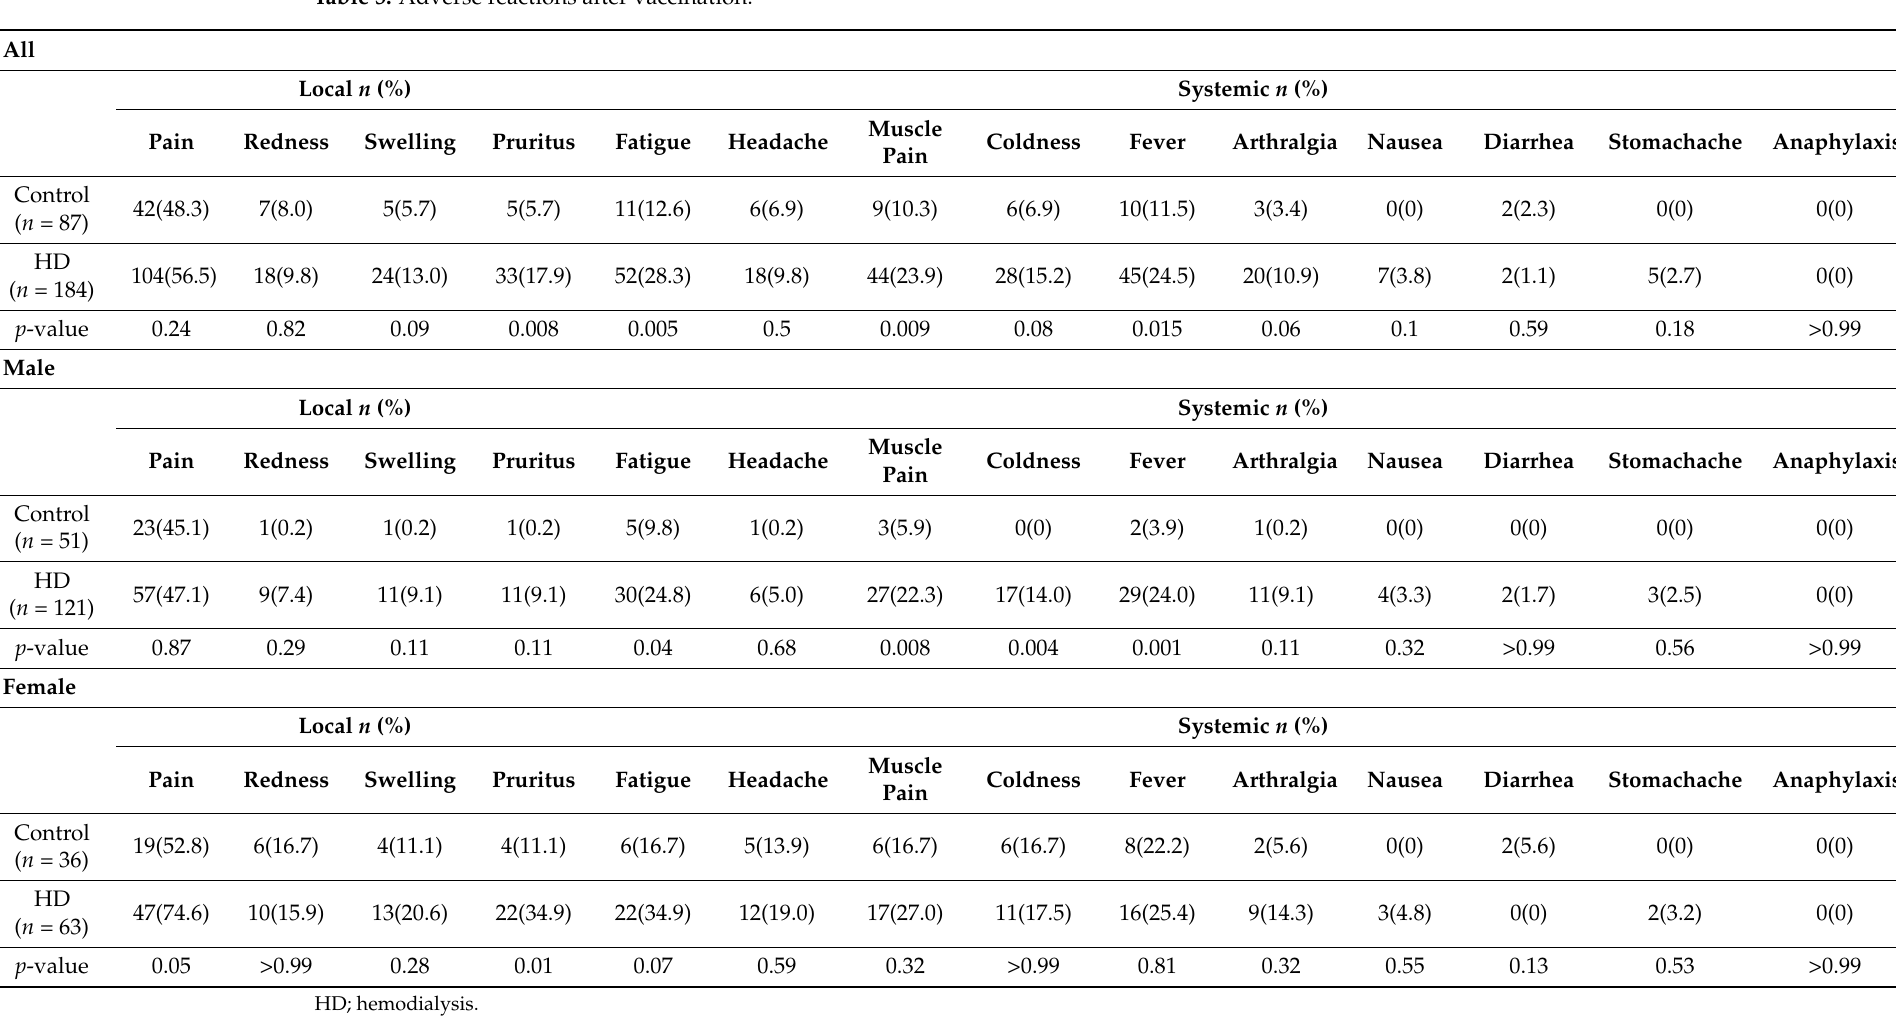
Table 5. Adverse reactions after